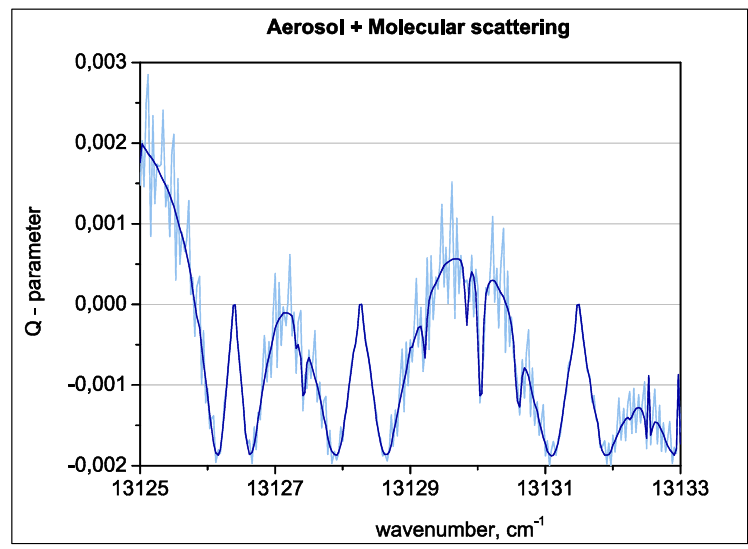
Figure 4. Spectra of the normalized Q -parameter at the zenith angle = 50° calculated by the first (light line) and second methods (dark line) (see